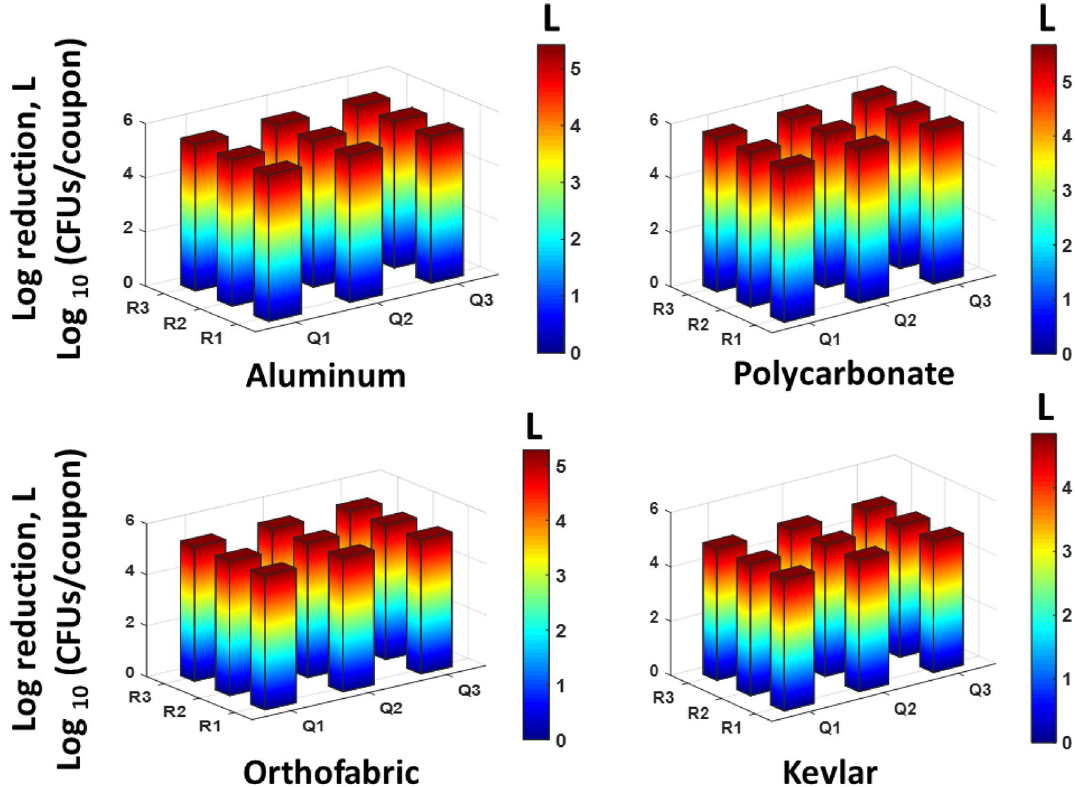
Figure 10. Data showing uniform spatial distribution of reduction in logs of E. coli CFUs/coupon of 9 exposed coupons placed at the central plane of the APS, for each material type. The x and y axis represent the location in the measurement grid illustrated in Fig. 4. Both the z axis and the color bar indicate log reductions achieved in the coupons—double representation was selected for clarity. Complete killing (4 to 5 log reduction) was achieved at all points using 4 CPPRs and exposures of 20 min (15 min CPPR on + 5 min CPPR